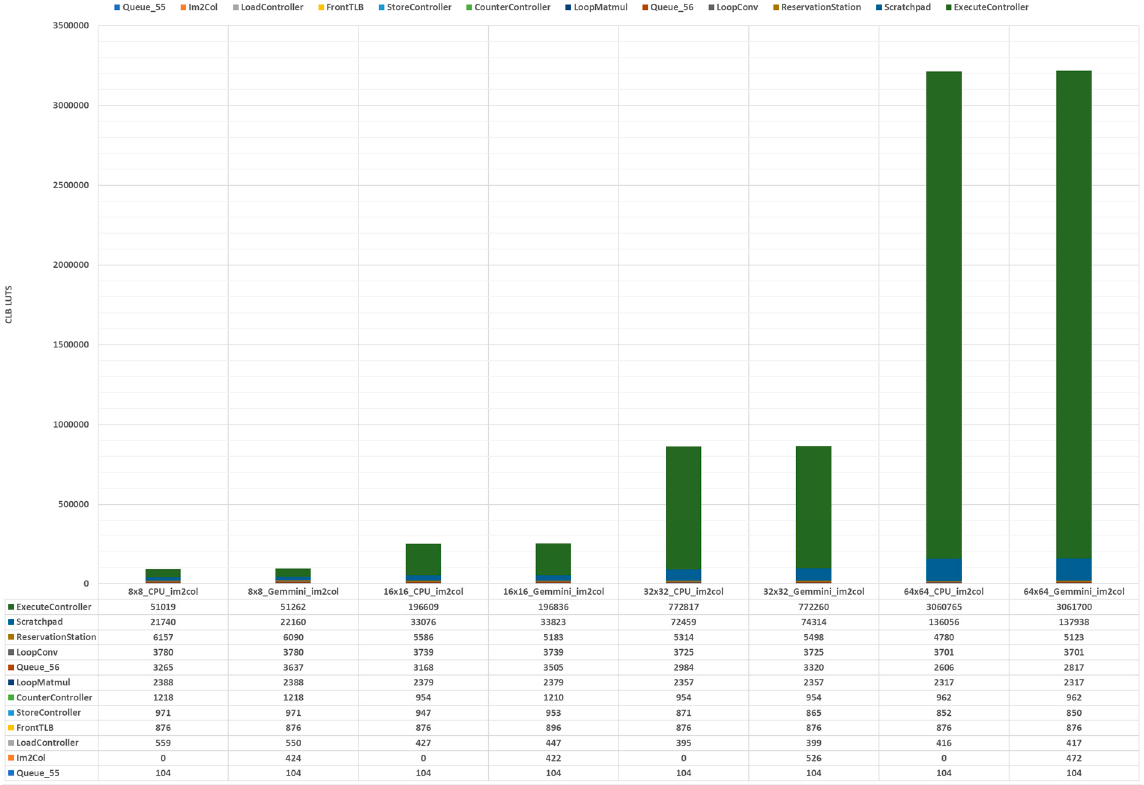
Figure 16. Gemmini modules CLB LUT usage.